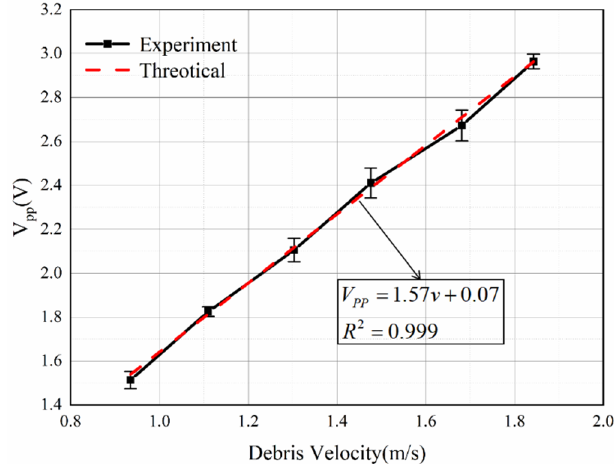
Figure 15. The V pp values of the induced voltage versus velocity.